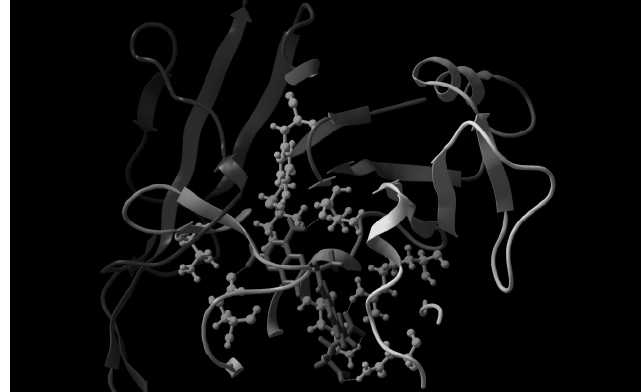
Figure 3. DHFR protein with ligand of pteridyl group showing 6 hydrogen bonds with the active site